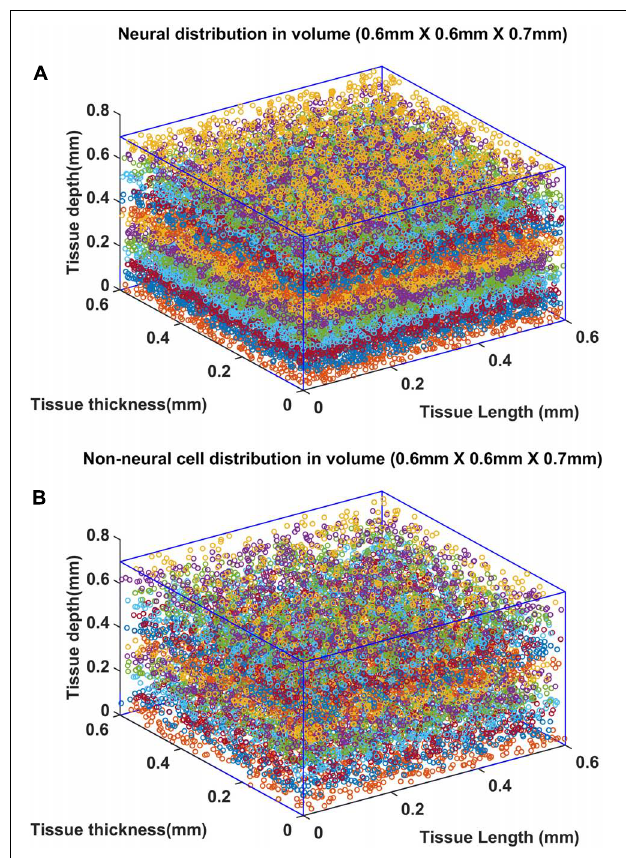
FIGURE 11 | Distribution of (A) neural and (B) non neural cells in a larger volume (0.6 mm × 0.6 mm × 0.7 mm). The deepest point along the depth of the cortex is considered as the origin (0,0,0). The surface of the cortex is at Z = 0.7 mm and deepest point of the cortex is at Z = 0 mm.